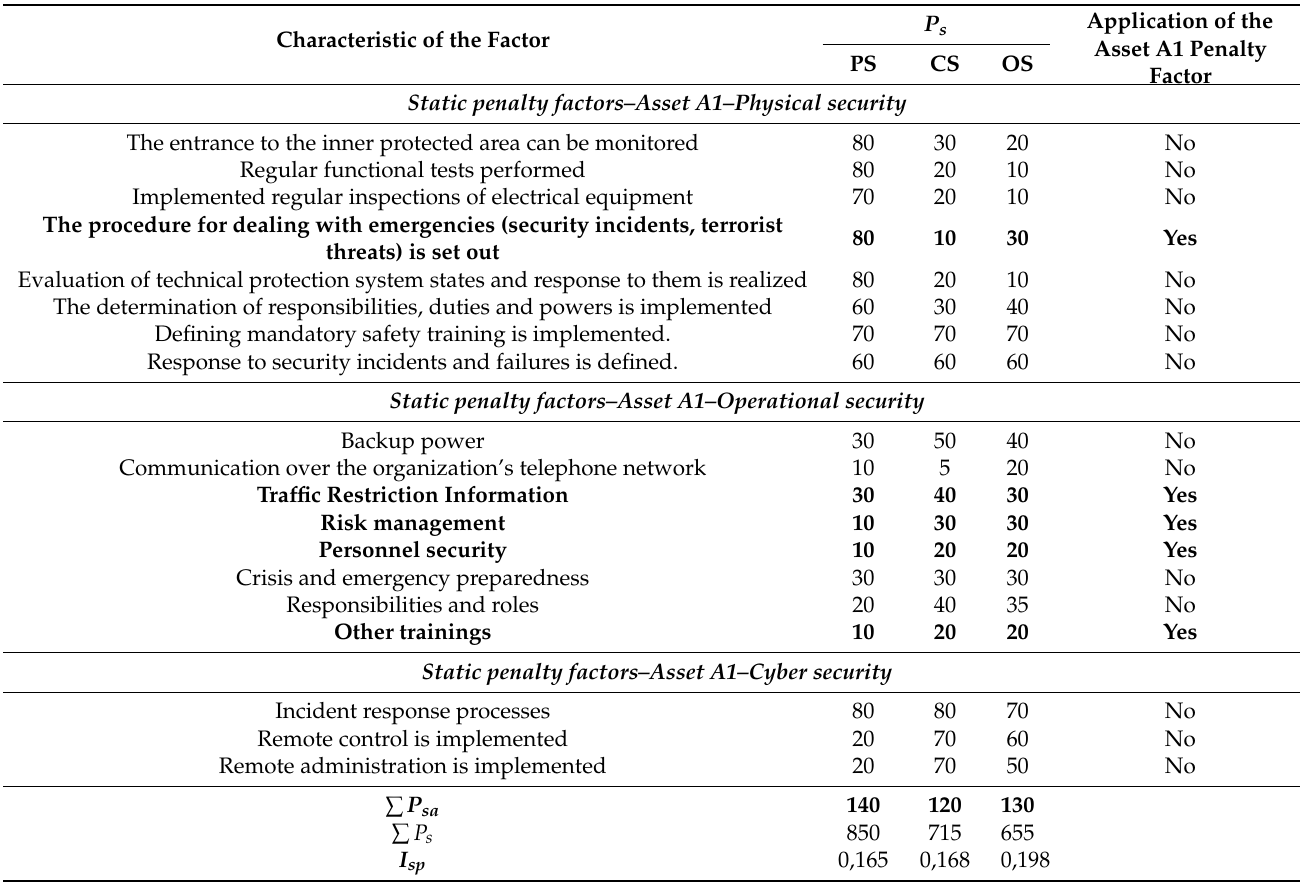
Table 3. Static penalty factors applied to reference object asset A1 and calculation of the asset static penalty. Characteristic of the Factor